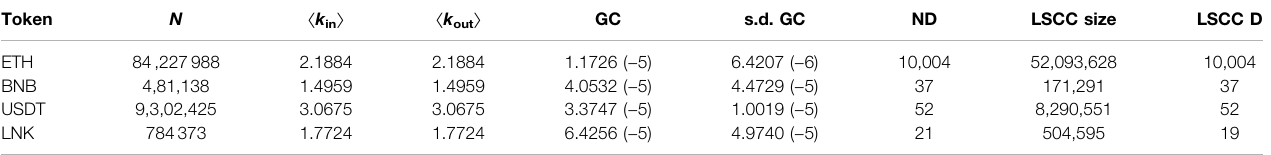
TABLE 3 | Basic Network properties for the different tokens. N is the number of nodes, 〈 k in 〉 is the average in-degree, 〈 k out 〉 is the average out-degree, GC is the Global Clustering Coef fi cient while s.d. GC is the standard deviation for the Global Clustering coef fi cient. ND is the network diameter, LSCC Size is the Largest Strongly Connected Component Size expressed in nodes while LSCC D is the Largest Strongly Connected Component